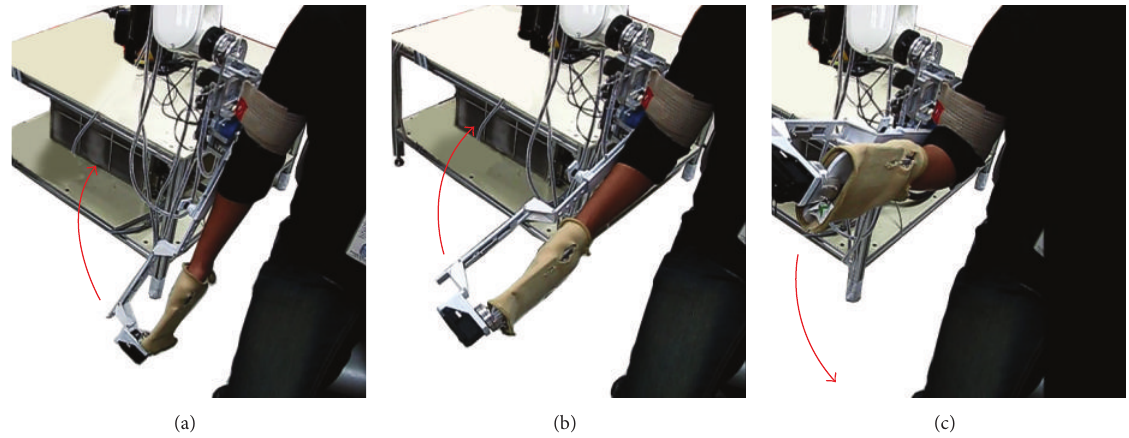
Figure 11: Example movements of SEFRE Rehab System: elbow extension-flexion.